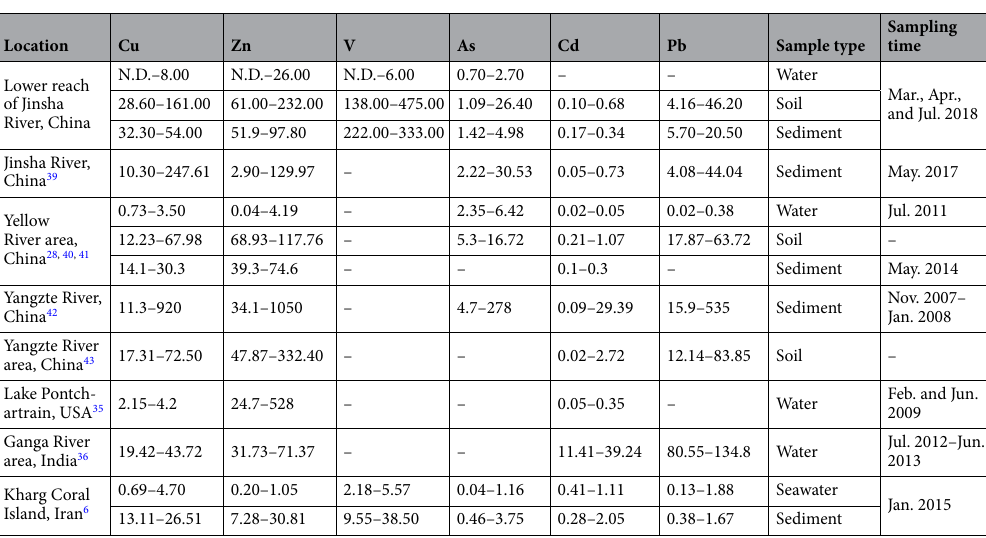
Table 2. Trace element levels in water, soil, and sediment from different countries/regions. The unit of trace element concentration is μg/L for water samples and mg/kg for soil/sediment